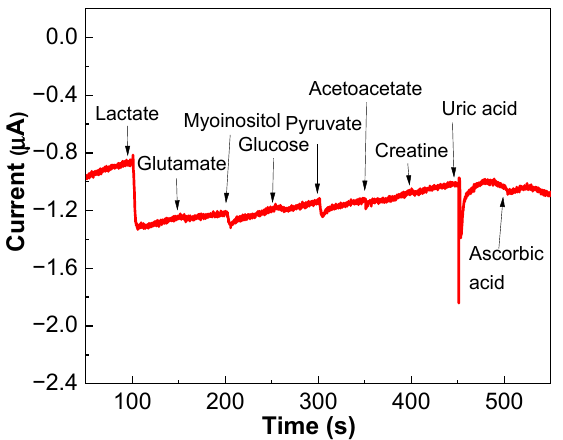
Figure 7. Chronoamperometric results of LOXENs/PB/SPCE in PBS (pH 7.4) at –0.1 V, following successive addition of 100 µM each of lactate, glutamate, myoinositol, glucose, pyruvate, acetoacetate, creatine, uric acid, and ascorbic acid.